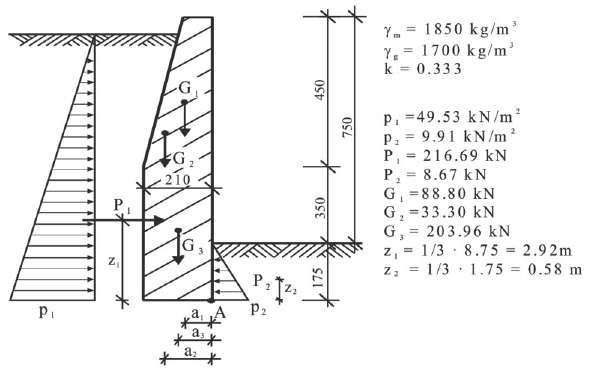
Fig. 11. Diagram of the loading to the eastern retaining